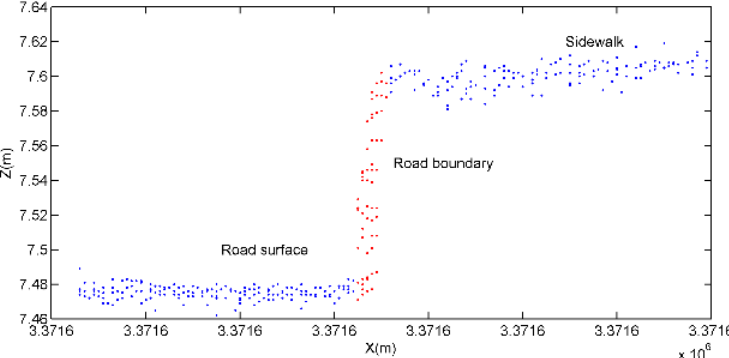
Figure 2. A sample of a road profile.